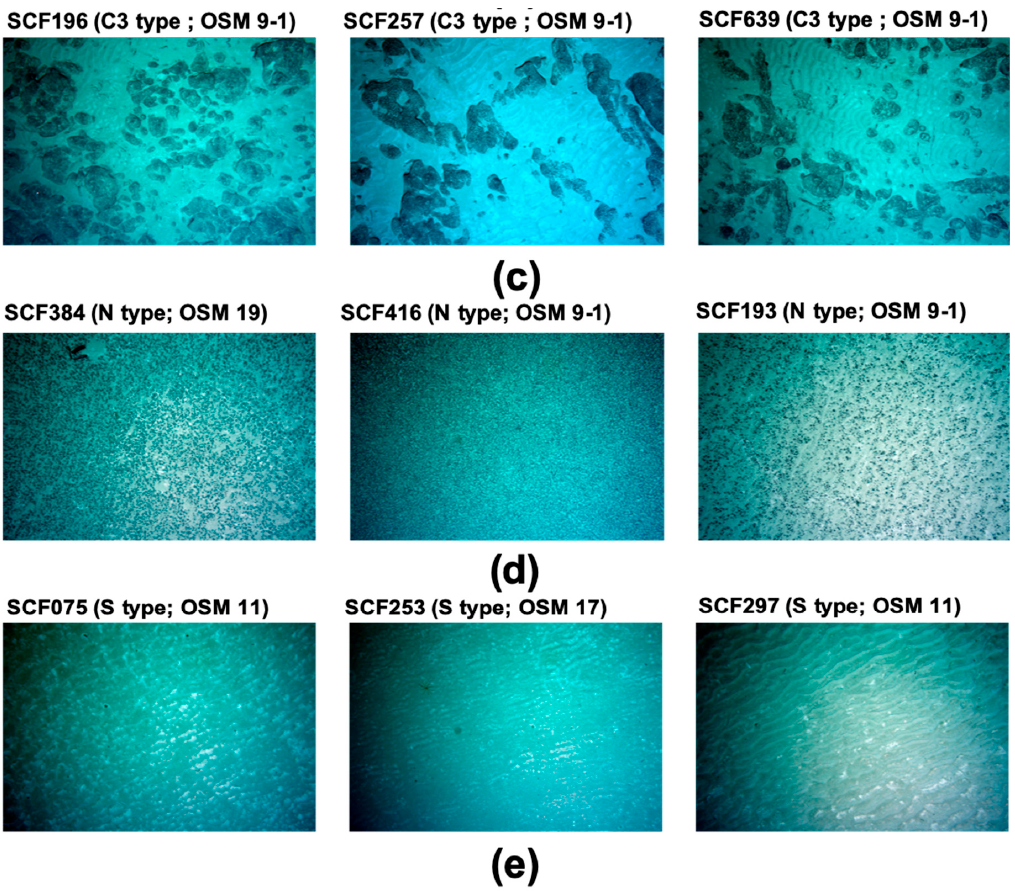
Figure 6. Examples of seabed types observed from the DCS: ( a ) crust-dominant floor (C1 type), ( b ) crust partially covered by sediments (C2 type), ( c ) crust covered by sediments with ripple marks (C3 type), ( d ) sediments covered by nodules (N type), and ( e ) sediments-dominant floor (S type). However, crust-covered bedrock with sediments is predominant in the center and edges of Type 2 seamount summits (OSM 15, 16, 17, 18, and 19) (Figure 8). S-type seabed is characterized by little population at OSM 16 and 18 (Figure 8a,b). Mixed seafloor types (C2 and C3) are the predominant substrates at the OSM 17 and 19 (Figure 8c,d). Consolidated sediments with polymetallic nodules are also observed at the boundary between two di ff erent seafloor types characterized at OSM 17 (tracks A–A’ and B–B’ in Figure